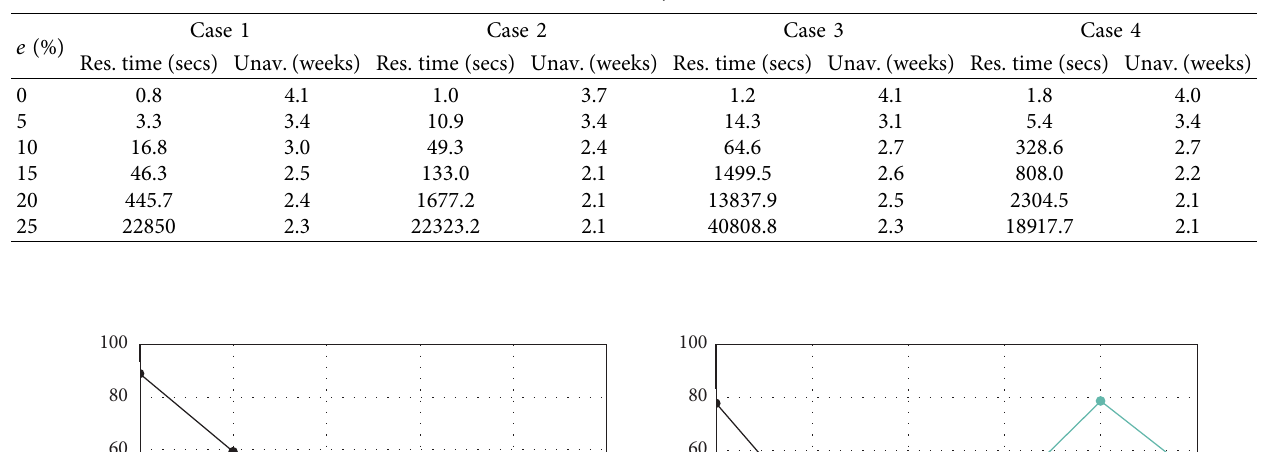
Table 10: Resolution times and unavailability results in order to tolerance factor e .